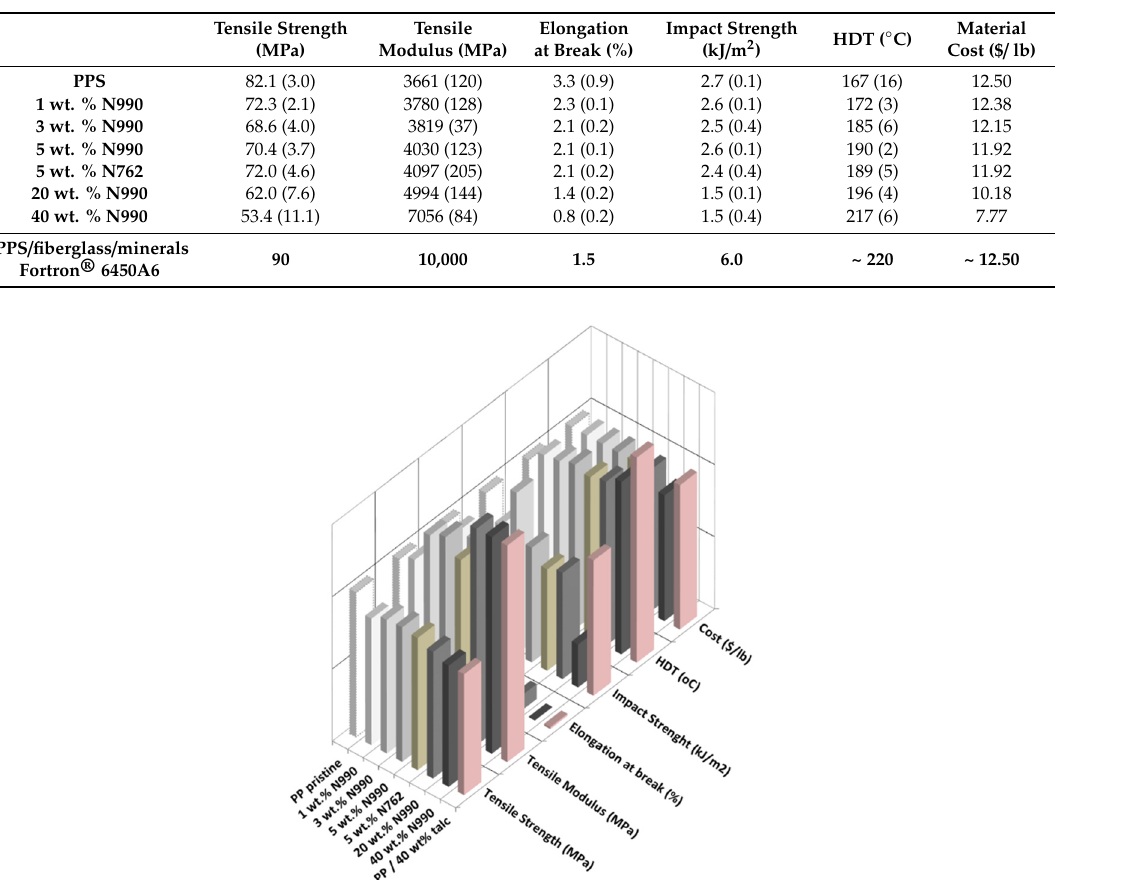
Table 4. Properties (and SD) of PPS / TB N990 composites.